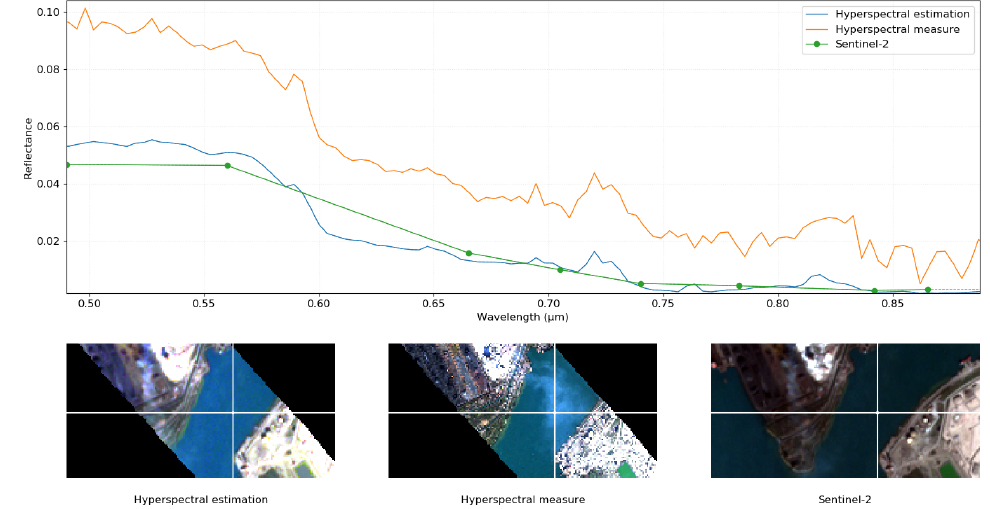
Figure 4. Estimated reflectance spectrum (blue) compare to the hyperspectral reflectance spectrum (orange) and the Sentinel-2 reflectance spectrum (green). The estimated reflectance, the measurements and the Sentinel-2 spectra are respectively associated to the left, the middle and the right panels.